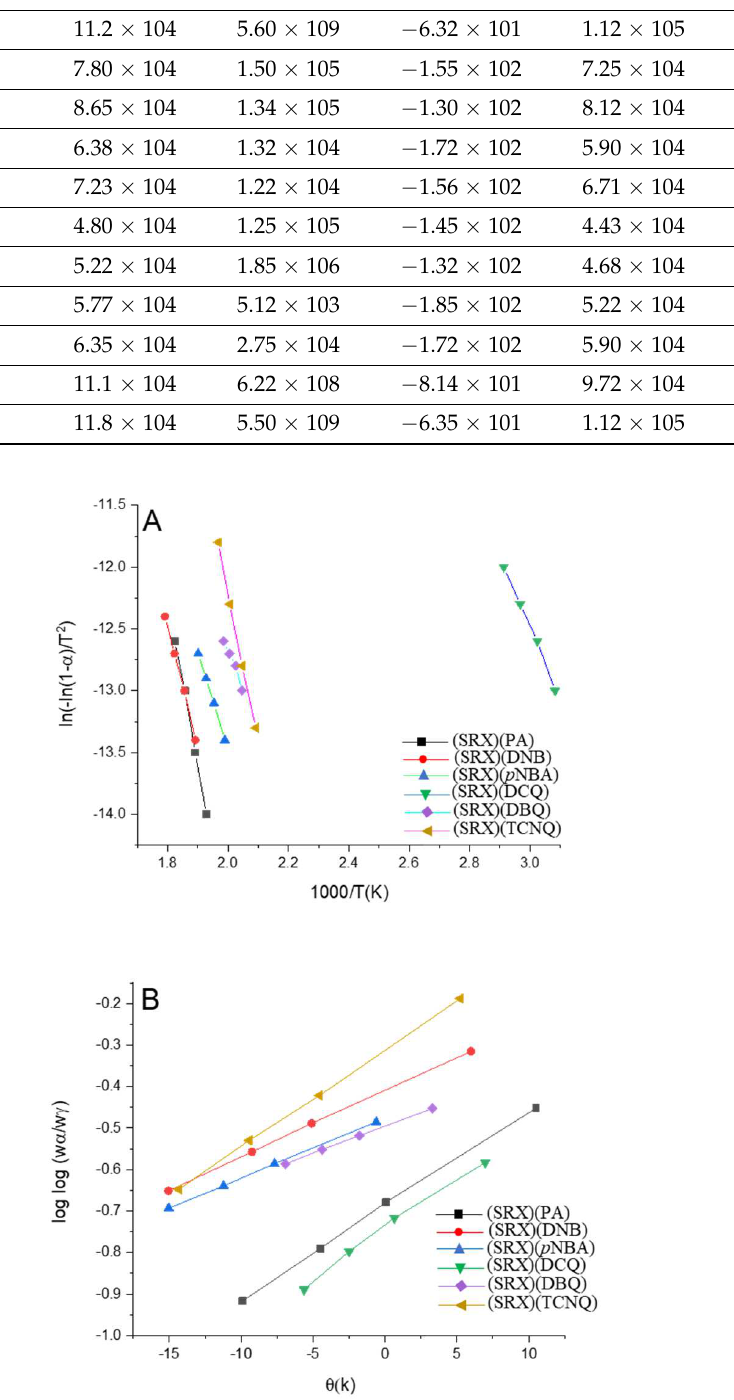
Figure 4. Kinetic curves of (1:1) charge-transfer complexes [(SRX)(π-acceptor)] using ( a ) Coats-Readfern and ( b ) Horowitez-Metzegar methods. Table 1. Kinetic thermodynamic parameters for the six charge–transfer complexes based on Coats– Redfern (CR) and Horowitz–Metzger (HM) methods.